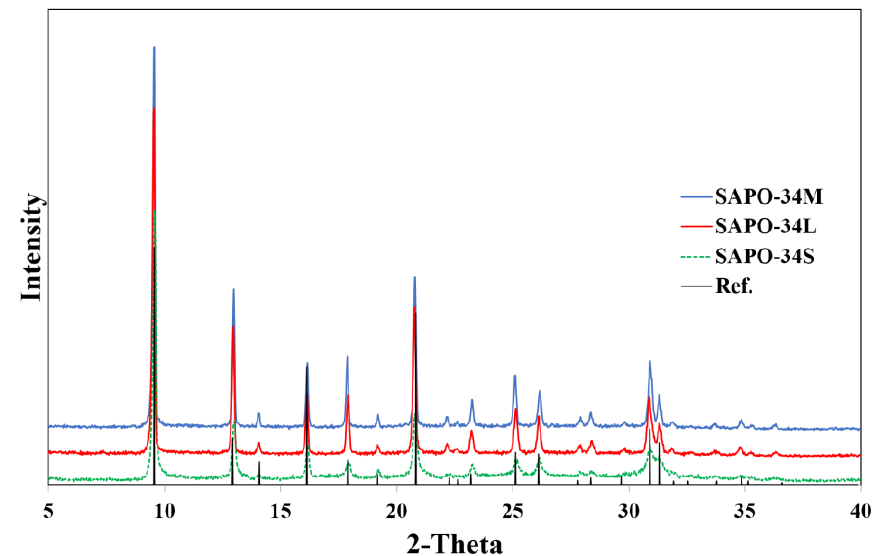
Figure 1. XR-diffractograms of the synthesized SAPO-34. Reference peaks are reported for comparison [42].